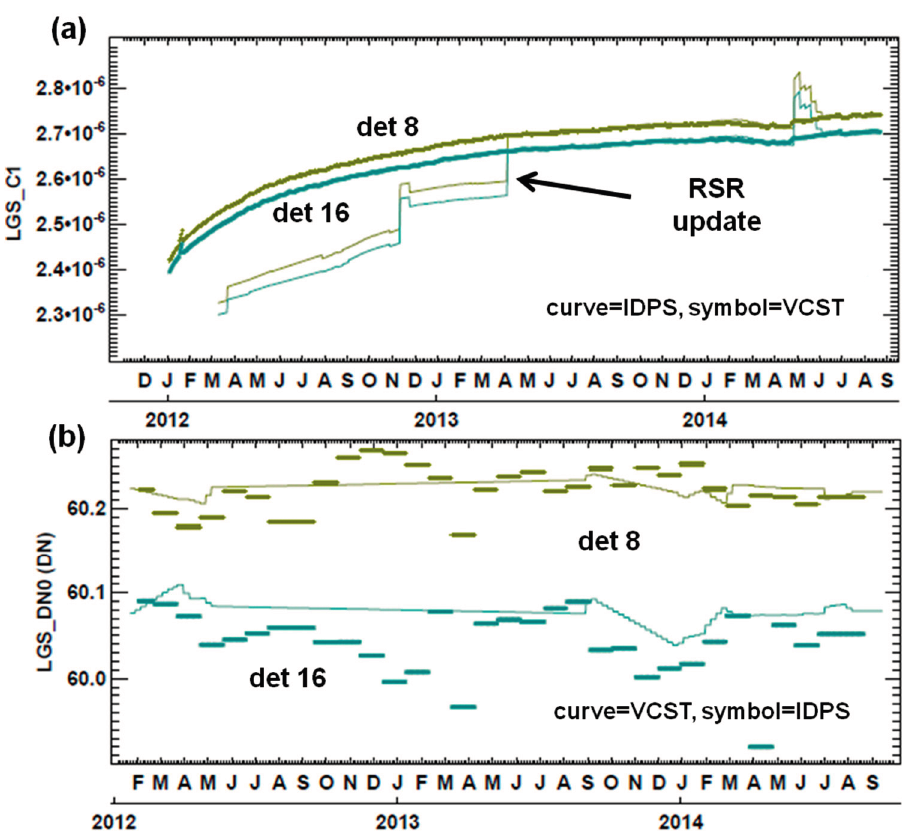
Figure 5. Comparison of daily averaged LGS gain and offset values between NASA and IDPS. ( a ) LGS gain coefficients (LGS_C1), in units of W·cm − 2 ·sr − 1 ; ( b ) LGS offset (LGS_DN0) in digital numbers (DNs). The plots show aggregation Mode 1, Detectors 8 and 16 as an example. VCST, VIIRS Characterization Support